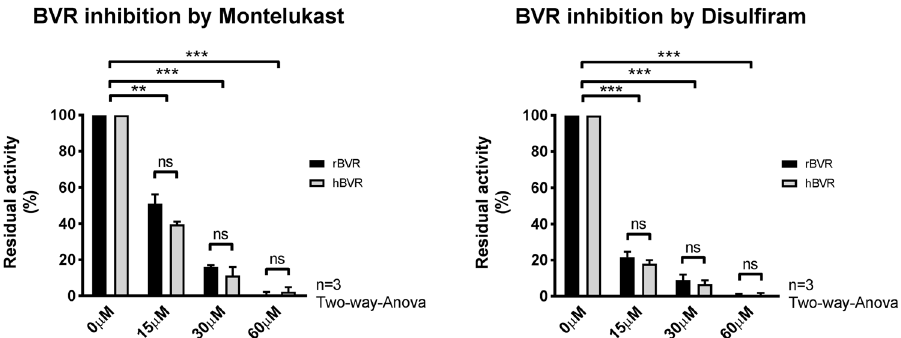
Figure 4. ( A ) Comparison between rat and human Biliverdin Reductase (rBVRA and hBVRA) activity in the presence of 0, 15, 30 or 60 μ M Montelukast or ( B ) 0, 15, 30 or 60 μ M Disulfiram. The conversion of biliverdin to bilirubin was determined by measuring absorbance over a period of 60 minutes at wavelengths 453 nm (bilirubin) and 670 nm (biliverdin). Biliverdin reductase activity was determined by calculating the slope over the linear part of the reaction and is expressed as residual activity relative to the vehicle control 1% DMSO. Data represent the mean ± SD of the data obtained from three independent experiments (n = 3). Two-way analysis of variance (ANOVA) was used for statistical analysis, ** p < 0.01, *** p <